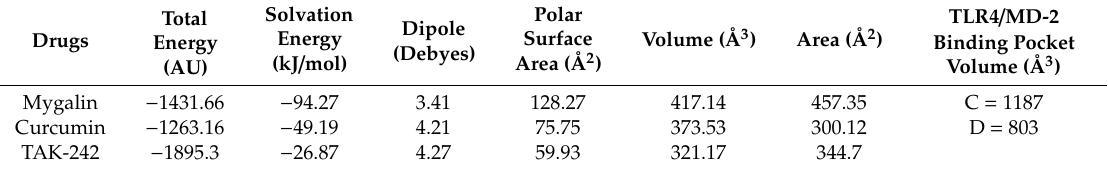
Figure 1. ( a ) Molecular structure of the ligands constructed in the program ChemDraw. ( b ) Electronic structure of the ligands in their lowest energy conformations, with curcumin in its enolic form. Electrostatic potentials and dipole moment vector (arrow) are shown. Table 3. Molecular properties of the ligands and volume of the binding pocket of TLR4 /